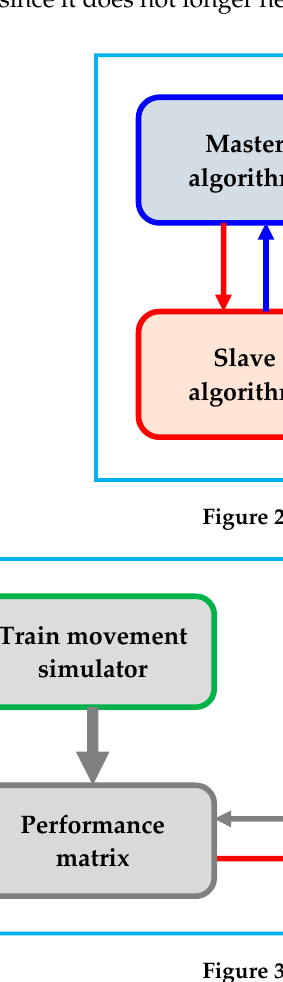
Figure 3. Approach 2 of the solution algorithm.